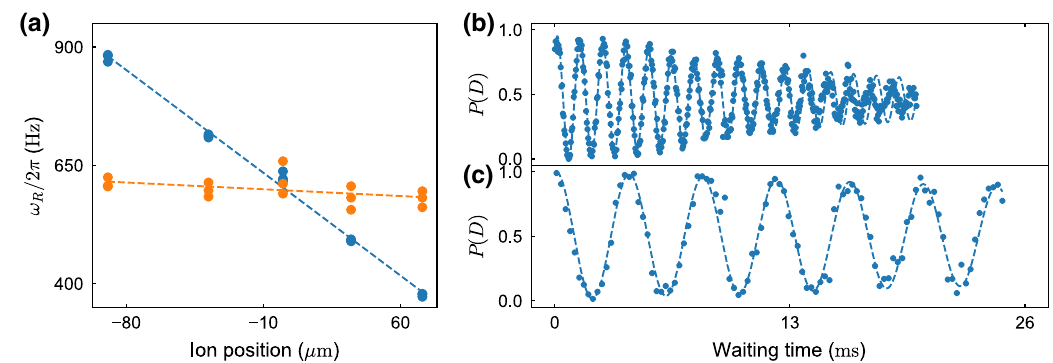
FIG. 14. (a) Magnetic field gradient before compensation (blue, 3.2 ± 0.1 Hz /μ m) and after compensation (red, 0.2 ± 0.1 Hz /μ m) on the ground state qubit as seen from the Ramsey fringe frequency ω R for a fixed detuning as a function of ion position, corrected for linear frequency drift at fixed position. (b) Decay of Ramsey fringes of the dark state population P ( D ) for the ground state qubit over = 18 ± 1 ms. (c) Same for the optical qubit transition. The sensitivity to magnetic fields is time, resulting in a coherence time of T GS 2 = 90 ± 30 ms. 5 times lower, leading to less impact from magnetic field noise. We determine T opt 2